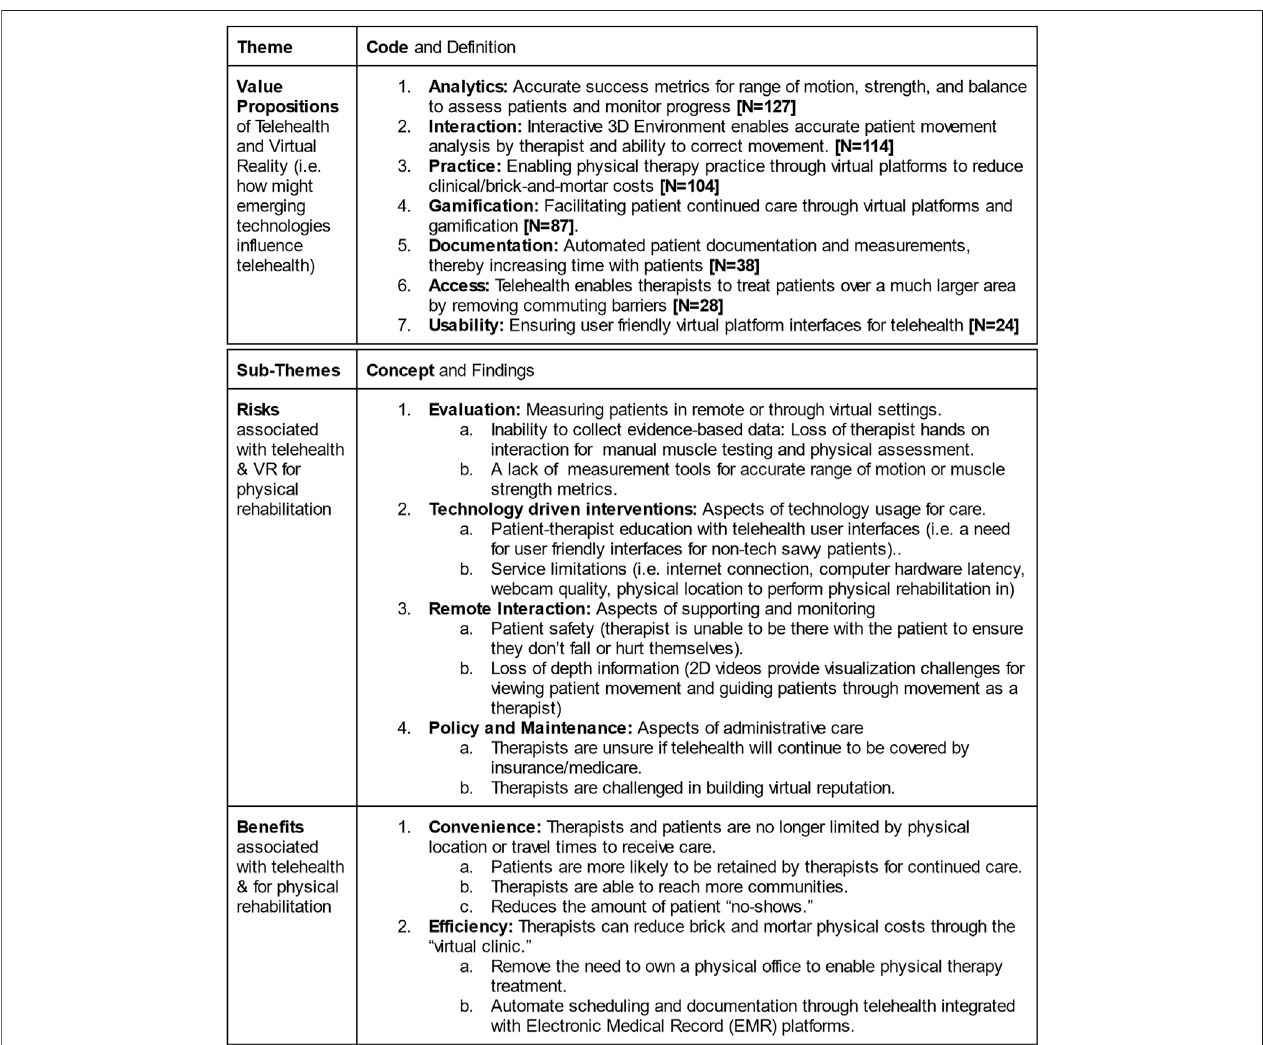
FIGURE 3 | Codebook and themes generated from interviews around technological challenges and opportunities for physical therapy telehealth. N indicates number of occurrences from interviews per top-level themes.